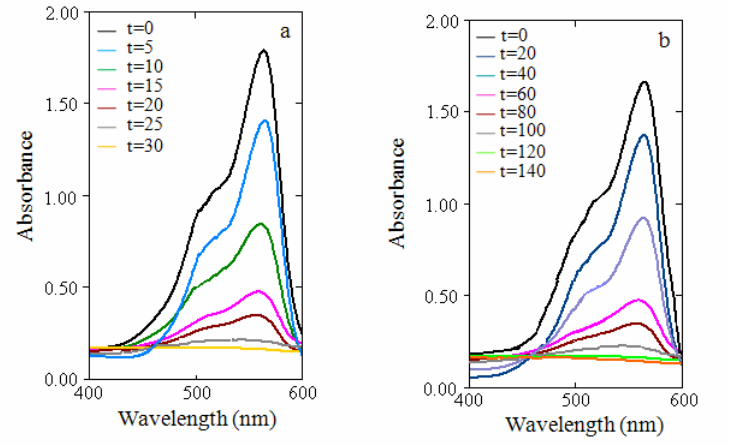
Fig. 5. Changes of UV-Vis spectra during the degradation of RB on a) TiO irradiation. 50 mg catalyst; 50 ml RB (10 mg l -1 ).